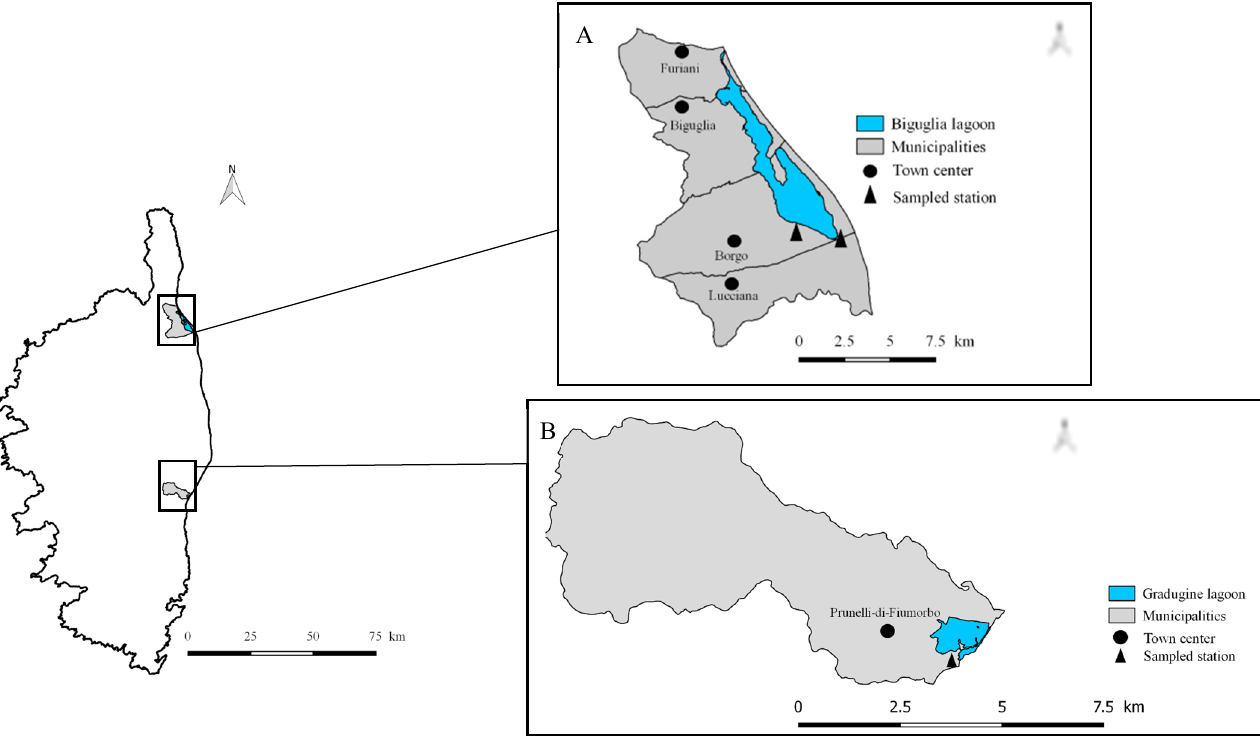
Figure 1. Map of Corsica with the sampled wetland locations ( A : Biguglia lagoon; B : Gradugine lagoon).